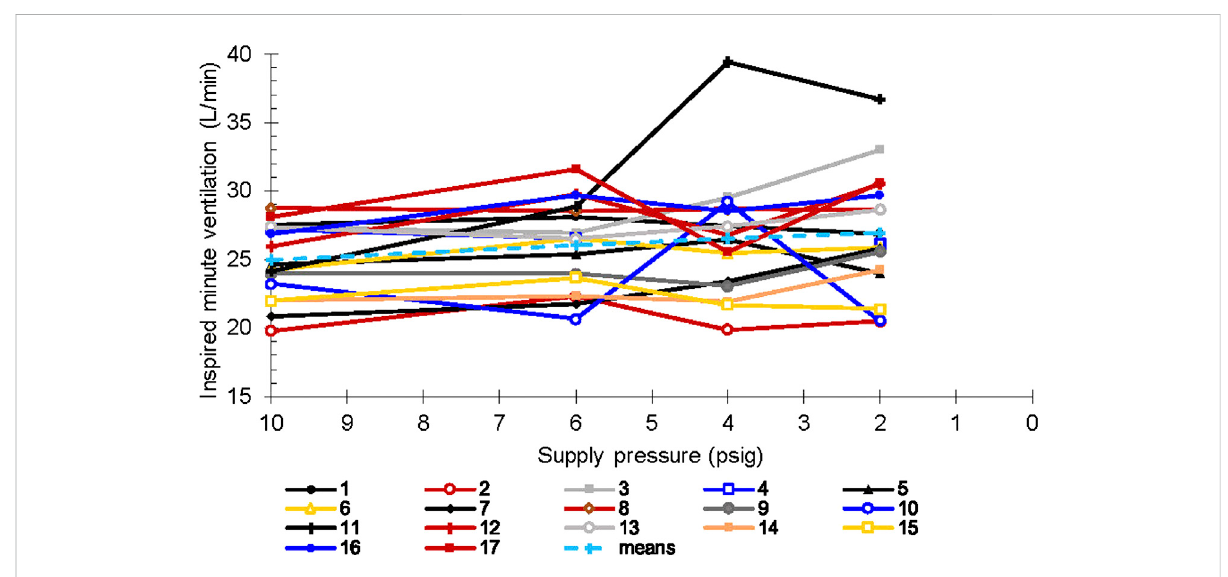
FIGURE 7 Minute ventilation vs . supply pressure. Each line represents a single